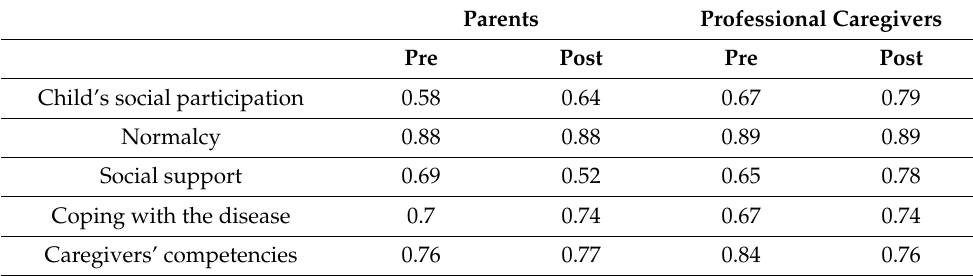
Table 5. McDonald’s ω for both questionnaire versions and both time